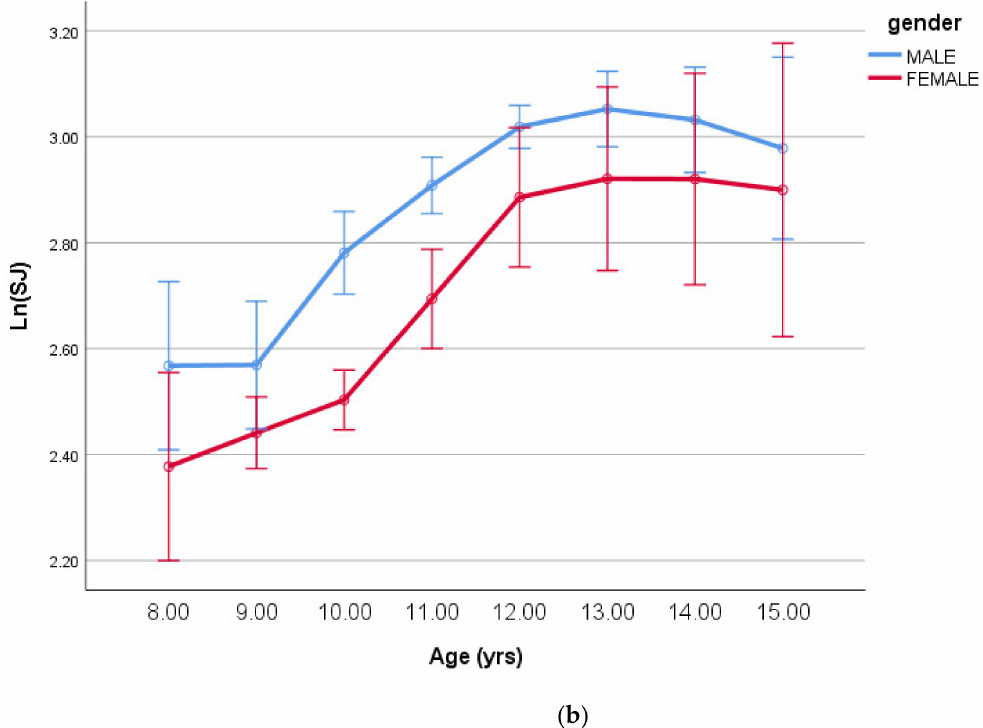
Figure 4. ( a ) Log-transformed counter-movement jump (means ± SE) by age having controlled for body size/shape and maturity offset (covariates in Table 4). ( b ) Log-transformed squat jump (means ± SE) by age having controlled for body size/shape and maturity offset (covariates in Table 4).